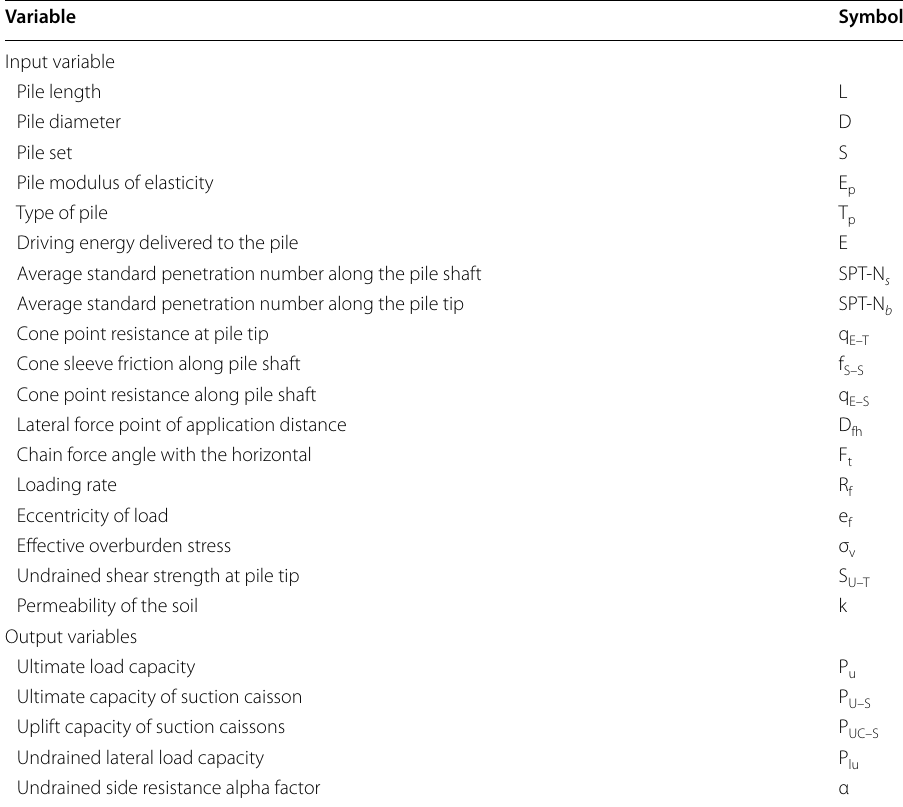
Table 3 GP input and output variables